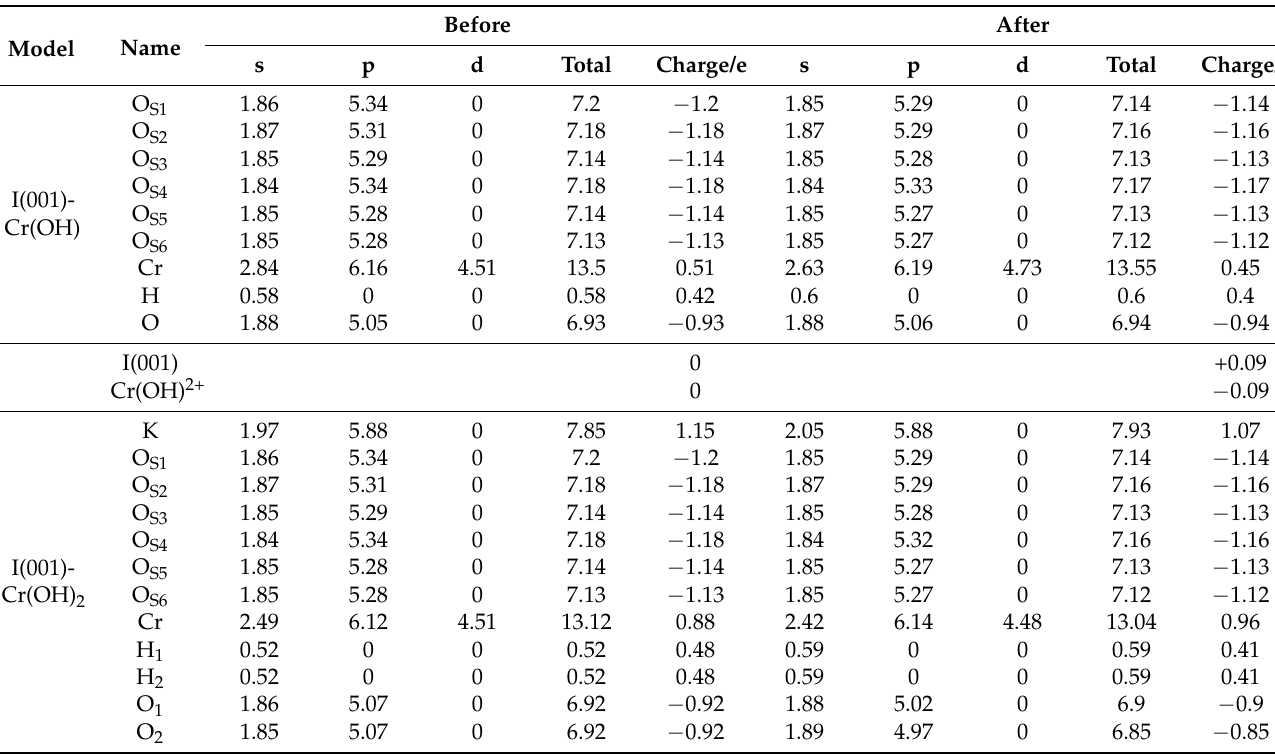
Figure 4. Electron density differences for Cr(OH) 2+ , Cr(OH) 2+ , and Cr(OH) 3 adsorbed on the illite (001) surface. The blue and yellow areas indicate increases and decreases in electron density, respectively. The isovalue is 0.008 e/Å 3 . Table 3. Atomic populations/charges of Cr(OH) 2+ , Cr(OH) 2+ , and Cr(OH) 3 before and after adsorption on the illite (001) surface, and changes in hydrolysate and surface charges.